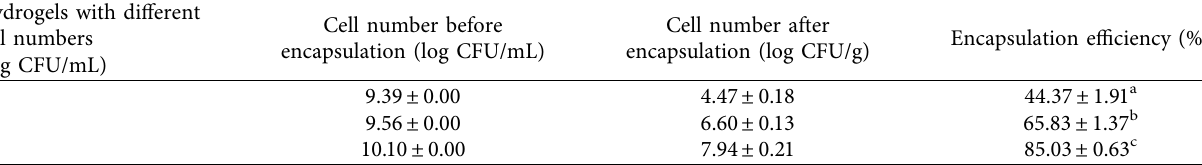
Table 1: Encapsulated cell numbers and hydrogel encapsulation efciencies with diferent initial cell numbers. Hydrogels with